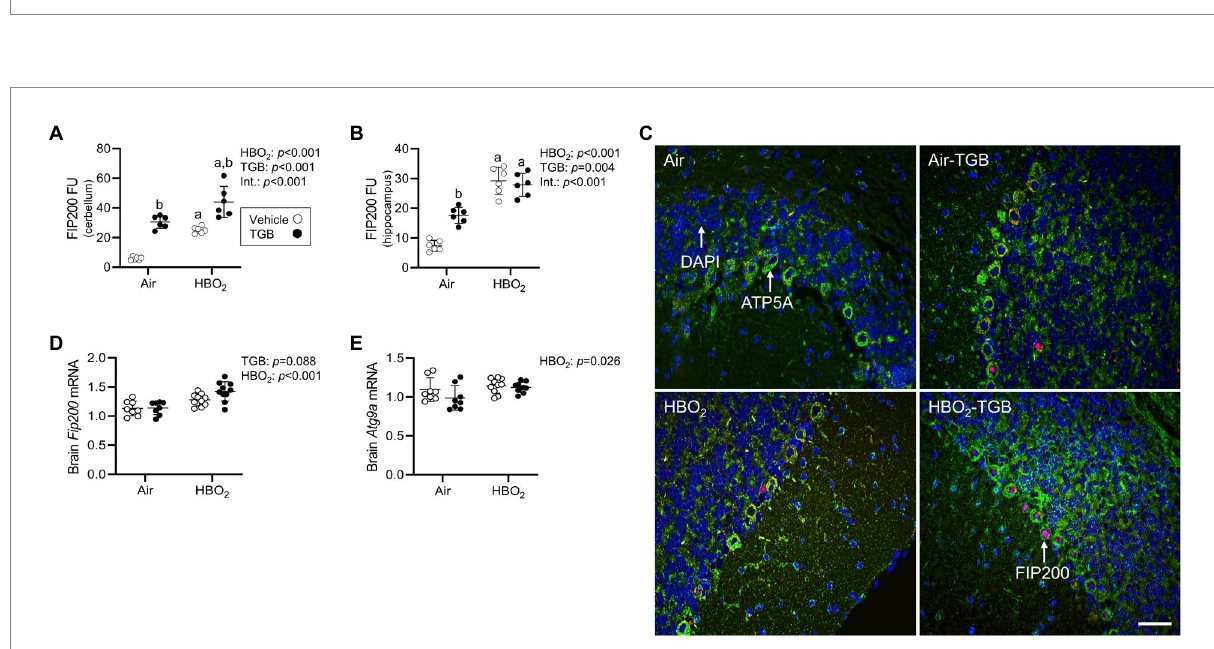
FIGURE 4 Mitophagy initiation in mice exposed to extreme HBO 2 . Mice were pretreated with 0.9% NaCl or TGB (4.8 mg/kg body weight) 30 min before exposure to air or 5 ATA oxygen for 30 min. (A,B) Quantification of PTEN-induced kinase 1 (PINK1) in the cerebellum and hippocampus. (C) Representative images from cerebellum. PINK1 (red), ATP synthase F1 subunit α (green) and DAPI (blue). Scale bar = 100 μ m. Main effect of a HBO 2 and b TGB, p < 0.05.